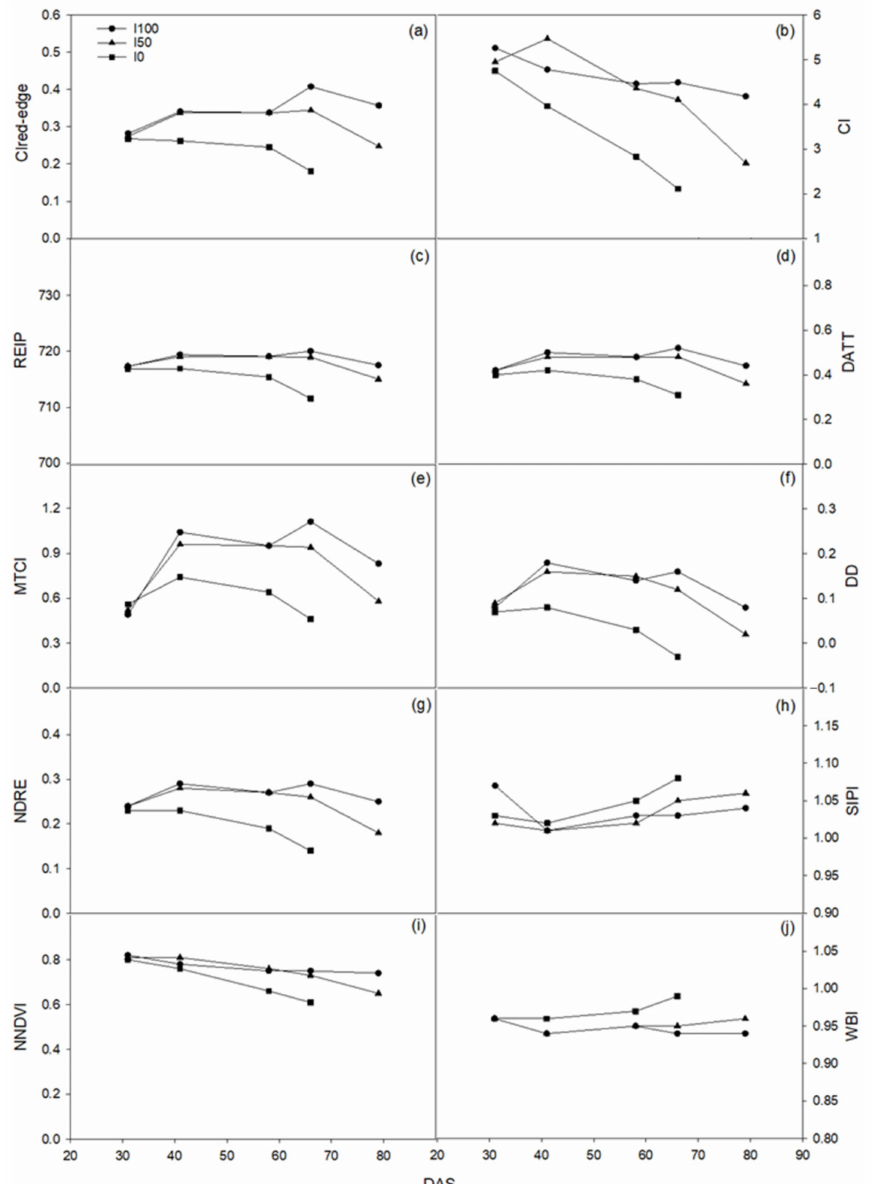
Figure 4. Variation in the CI red-edge ( a ), CI ( b ), REIP ( c ), DATT ( d ), MTCI ( e ), and DD ( f ). NDRE ( g ), SIPI ( h ), NNDVI ( i ), and WBI ( j ) during the growing season of sweet maize for different water and nitrogen